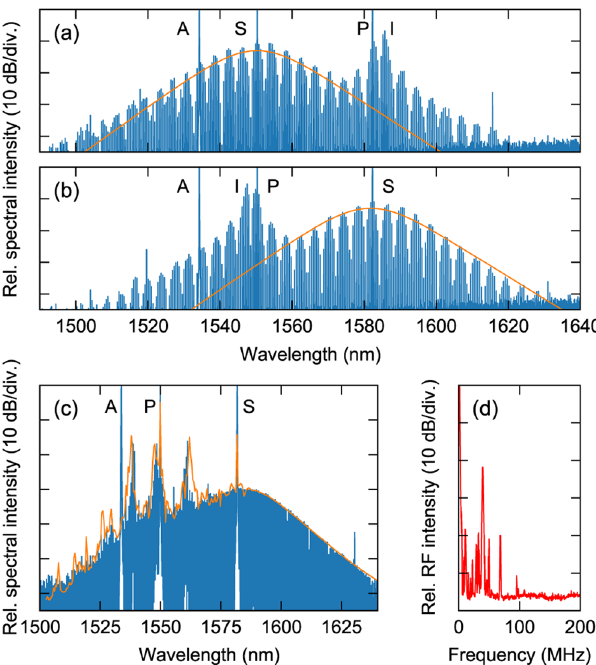
Fig. 5 Additional soliton-linear wave dynamics. Blue curves in ( a ), ( b ) show experimentally measured spectra at the resonator output when a two-cavity soliton state interacts with a probe. In ( a ) the solitons are at 1550 nm and the probe at 1583 nm, whilst in ( b ) the roles are swapped. The orange curves in ( a ), ( b ) show theoretically predicted cavity soliton envelopes in the absence of the probe wave, highlighting how the interaction leads to substantial spectral extension. c Blue and orange curves respectively show experimental and simulated optical spectra in the narrow parameter regime where the probe at 1550 nm undergoes modulation instability yet permits the cavity soliton at 1582 nm to persist. d shows the radio-frequency spectrum corresponding to ( c ), highlighting the low- coherence of the state. Labels A, I, P, and S respectively indicate the auxiliary laser used for thermal compensation, the idler, the probe, and the